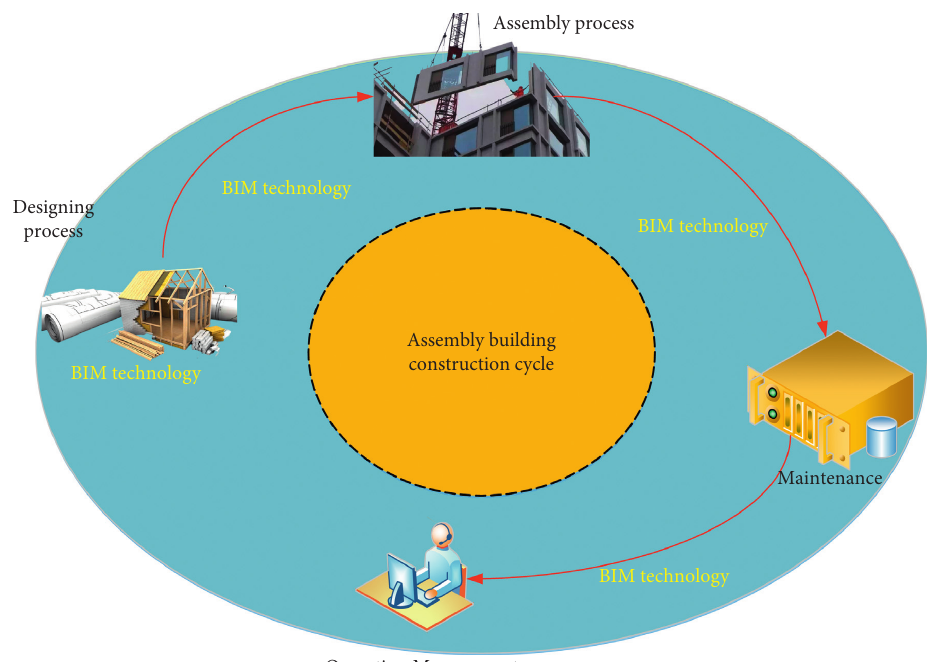
Figure 7: Diagram of BIM technology application